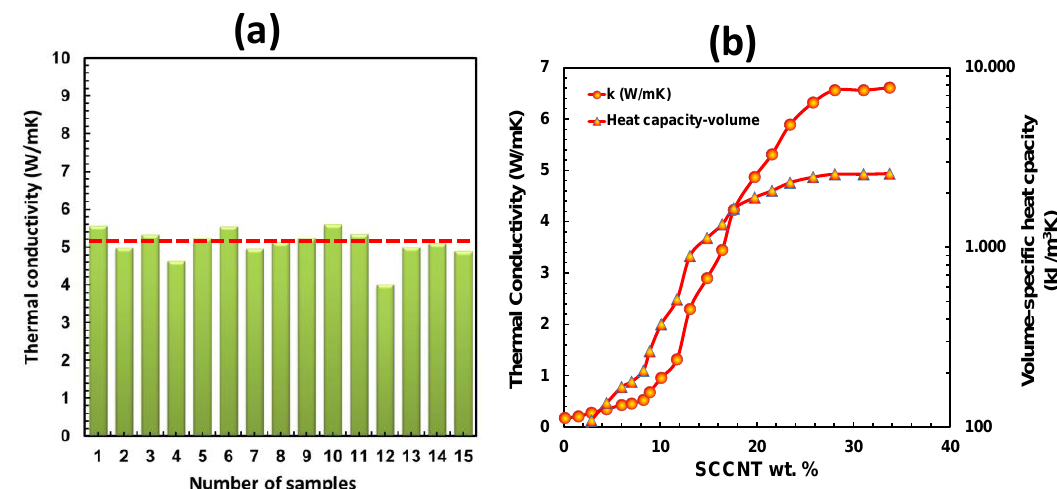
Figure 10. ( a ) Thermal conductivity of 15 different samples of 20 wt % SCCNT-containing biocomposite with an average value of 5.1 W/mK and ( b ) changes in thermal conductivity and volume-specific heat capacity of the biocomposites as a function of SCCNT concentration.